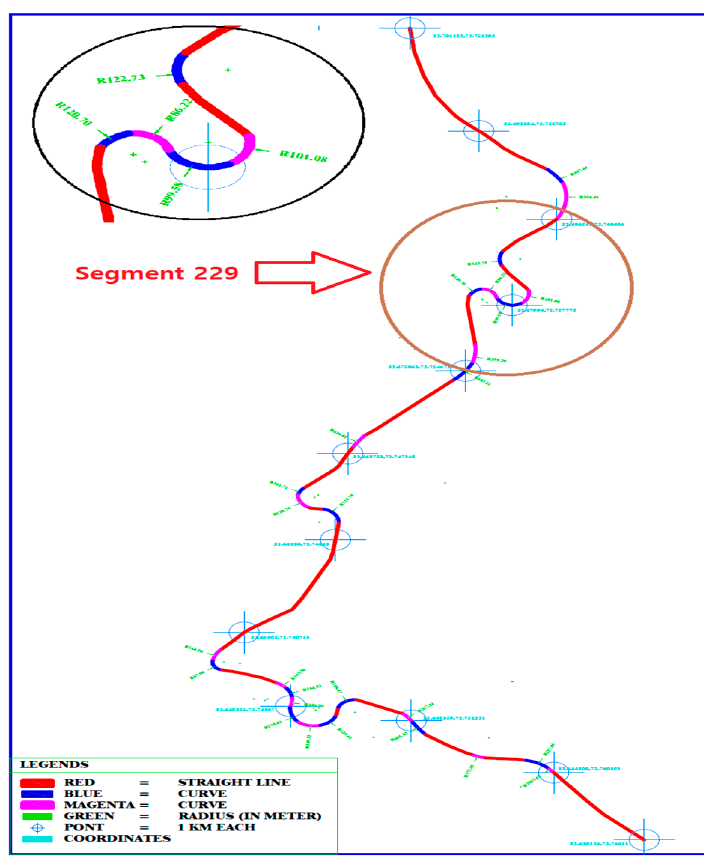
Figure 8. Ranked No.1 top-most risky segment.